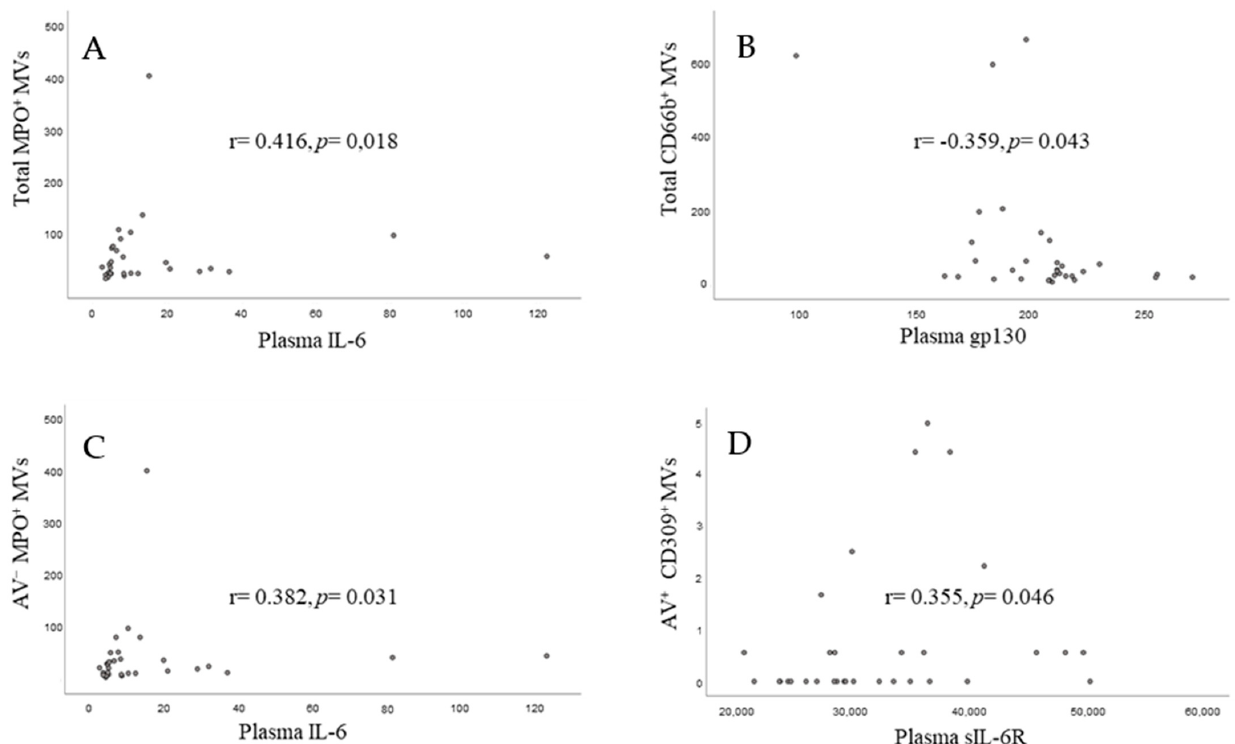
7 of 12 Figure 1. Scatterplots visualizing the correlations between NLRP3 gene expression in thrombi and circulating CD61 + MVs ( A ) and AV + MVs derived from platelets ( B , F ), leukocytes ( D ), endothelial ( C ), and MPO + ( E ) cells. Abbreviations: MPO—myeloperoxidase.